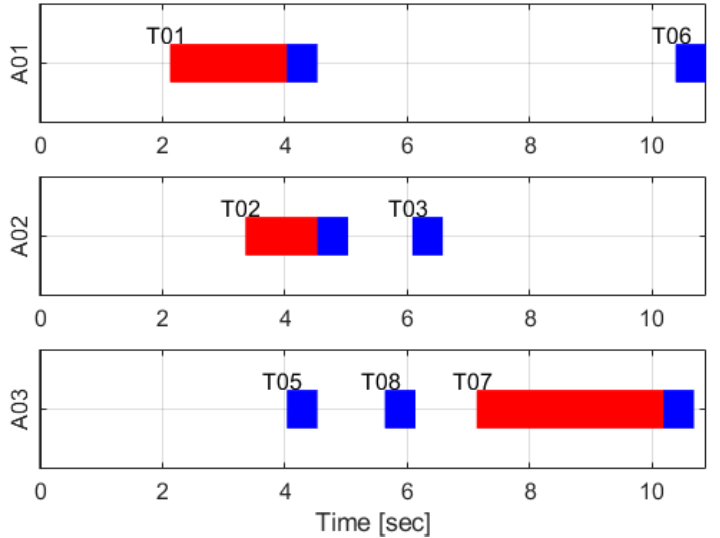
Figure 9. Timetable result of TACTAR for a complicated case applying a modified time-discounted reward scheme.